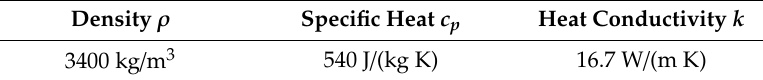
Table 4. Thermophysical properties of nanoparticles (Si 3 N 4 ).